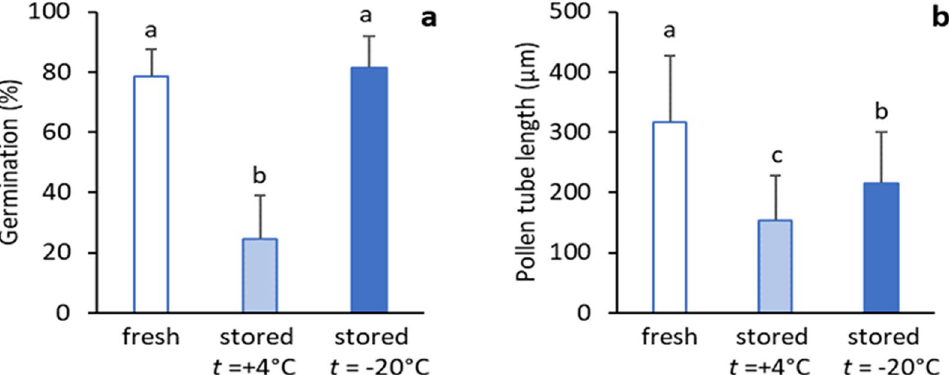
Figure 2. Average values of pollen germination percentage ( a ) and pollen tube length ( b ) of five shrubs of each fresh pollen and pollen stored at + 4 °C and − 20 °C. Different letters refer to the statistical significance of the differences between three groups of tested pollen, as revealed by Duncan’s pairwise tests.